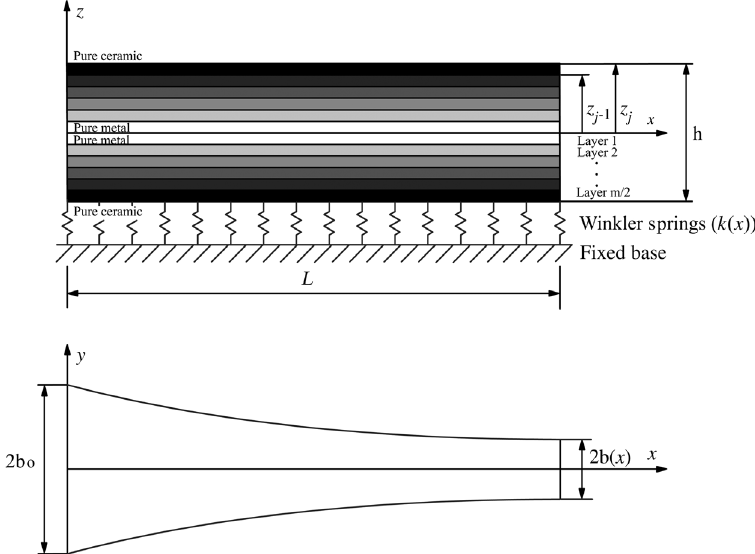
Figure 1 An FG sandwich beam with variable cross section on variable Winkler